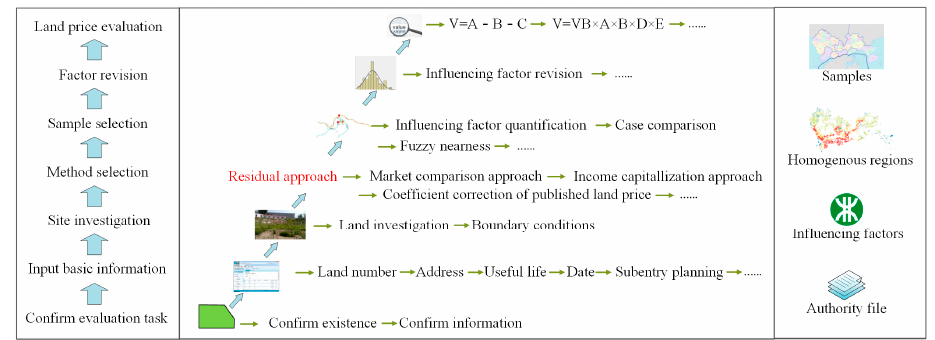
Figure 8. Common evaluation process using the residual method.